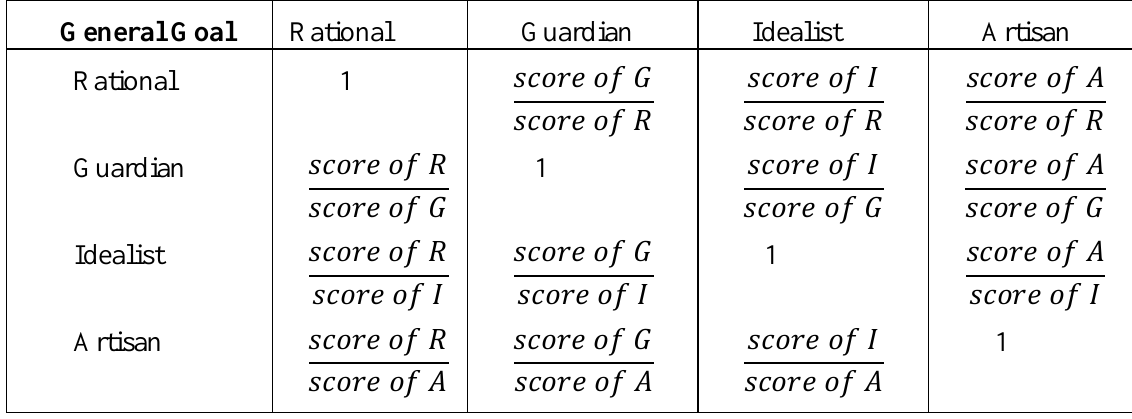
Table 4: Pairwise comparison matrix between Temperament and General